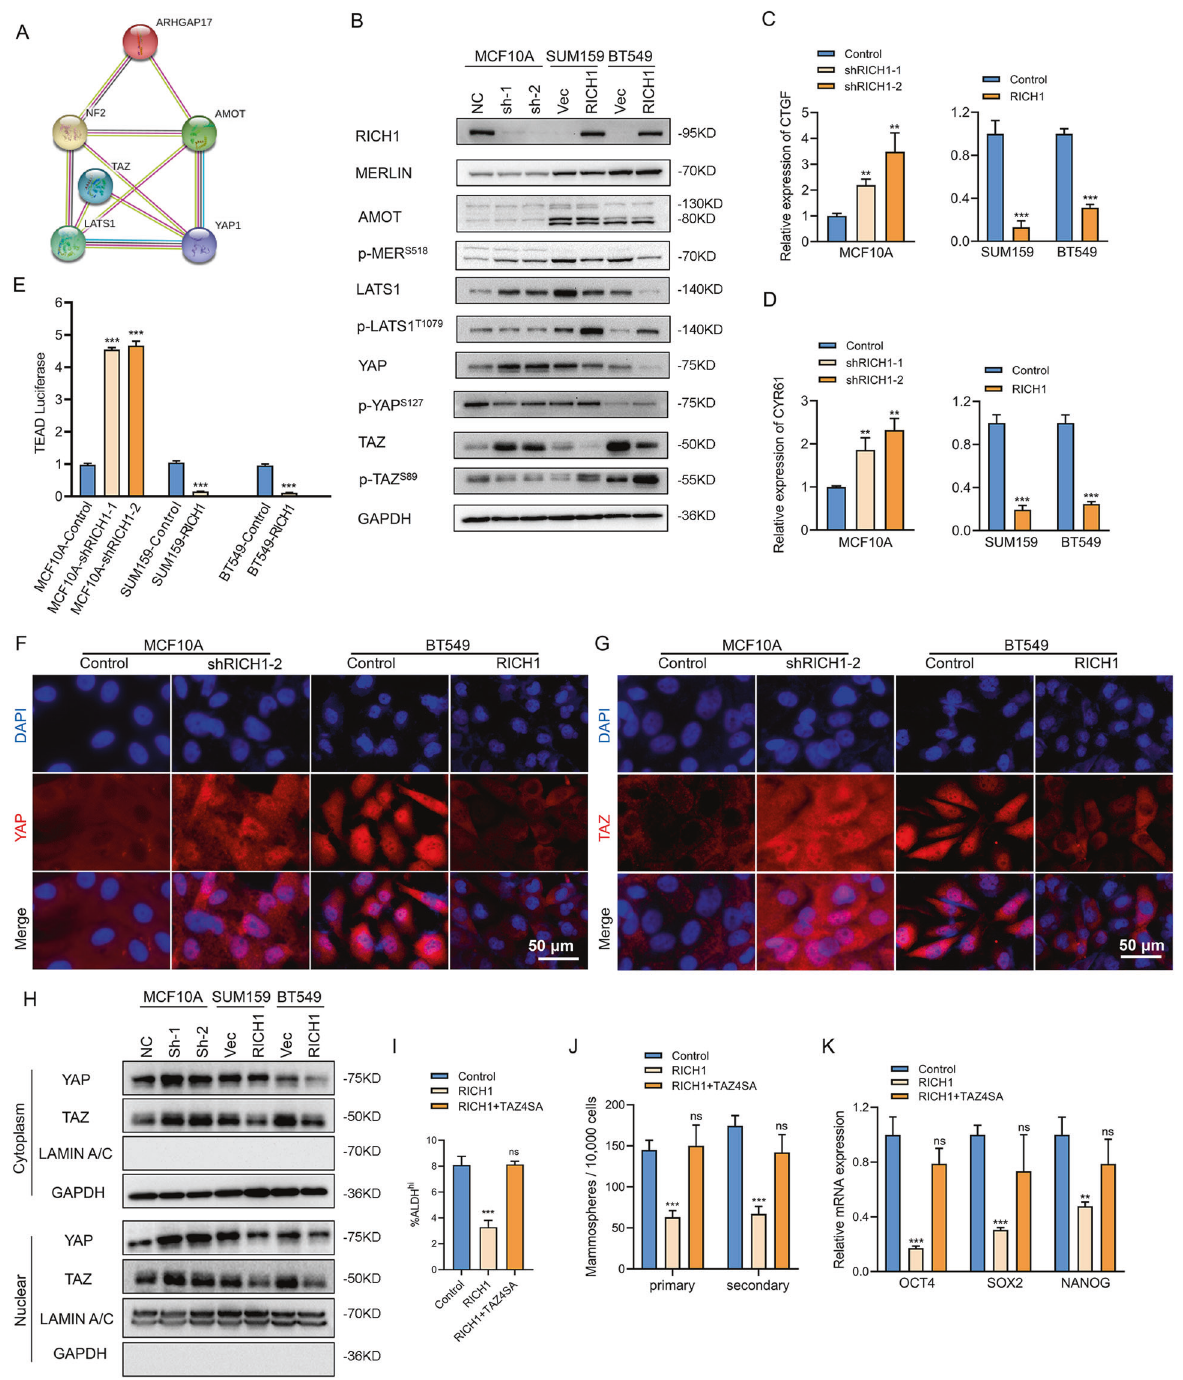
Fig. 5 RICH1 activates the kinases cascade of Hippo signaling and inhibits nuclear translocation of YAP/TAZ. A The protein-protein interaction network between RICH1 and main regulators and effectors of Hippo signaling identi fi ed by STRING database. ARHGAP17-gene symbol for RICH1; NF2-gene symbol for MERLIN. B Detection of main regulators and effectors of Hippo signaling after RICH1 knockdown and overexpression by Western blotting. C, D The mRNA expression levels of YAP/TAZ target genes CTGF (C) and CYR61 (D) assayed by real time PCR. E TEAD-luciferase reporter analysis in RICH1-knockdown and -overexpressing cells. F , G Localization of YAP and TAZ shown by immuno fl uorescence assays. H Cytoplasmic and nuclear expression of YAP and TAZ determined by Western blotting. GAPDH was used as the loading control for the cytoplasmic protein. Lamin A/C was used as the loading control for nuclear protein. I Quantitation of ALDH hi subpopulations in BT549 with RICH1 overexpression and TAZ4SA transduction. J Quantitation of primary and secondary tumorsphere formation in BT549 cells with RICH1 overexpression and TAZ4SA transduction. K Relative mRNA expression levels of CSC-TFs (OCT4, SOX2, and NANOG) in BT549 cells with RICH1 overexpression and TAZ4SA transduction. All the experiments were repeated three times independently with similar results. Data represent mean ± SD. Statistical signi fi cance was determined by two-tailed unpaired t -test. Abbreviation: ns, not signi fi cant; ** p < 0.01; *** p < 0.001.